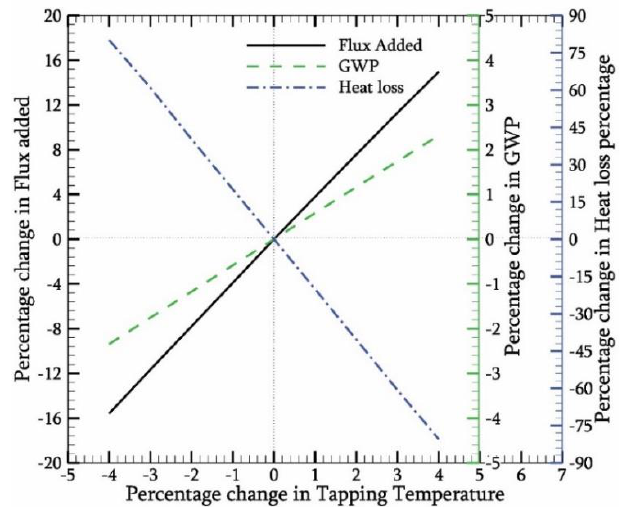
Figure 5. Effect of change in temperature on flux added, change in GWP, and change in heat loss percentage.